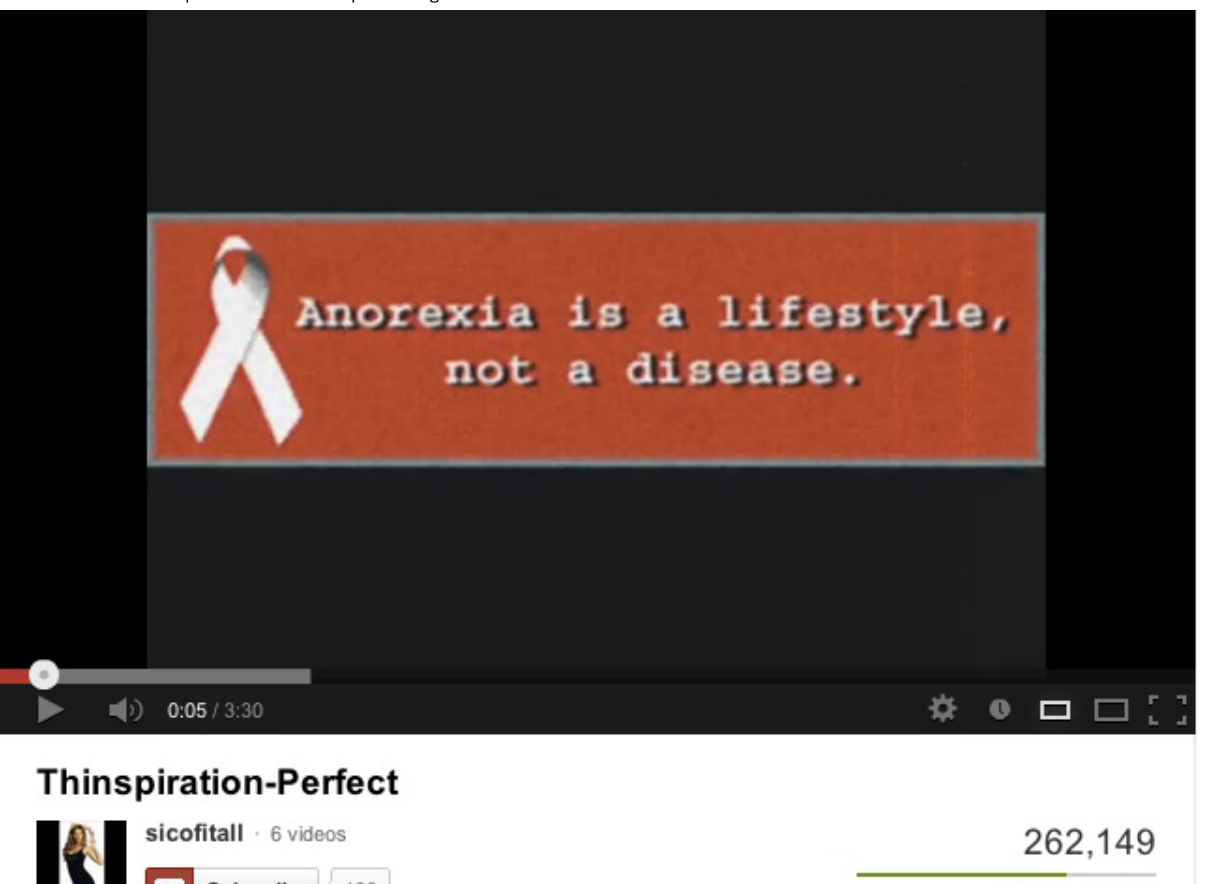
Figure 1. Screenshot of a pro-anorexia video promoting